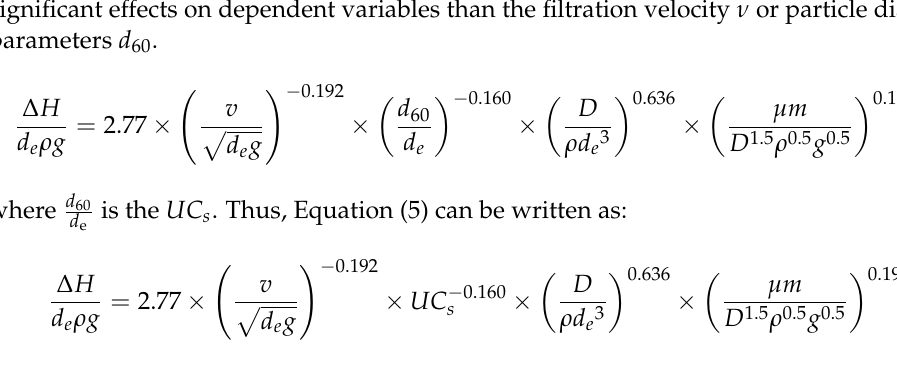
Table 6. Statistical parameters comparison of calculated ∆ H from equations and measured ∆ H , Pa